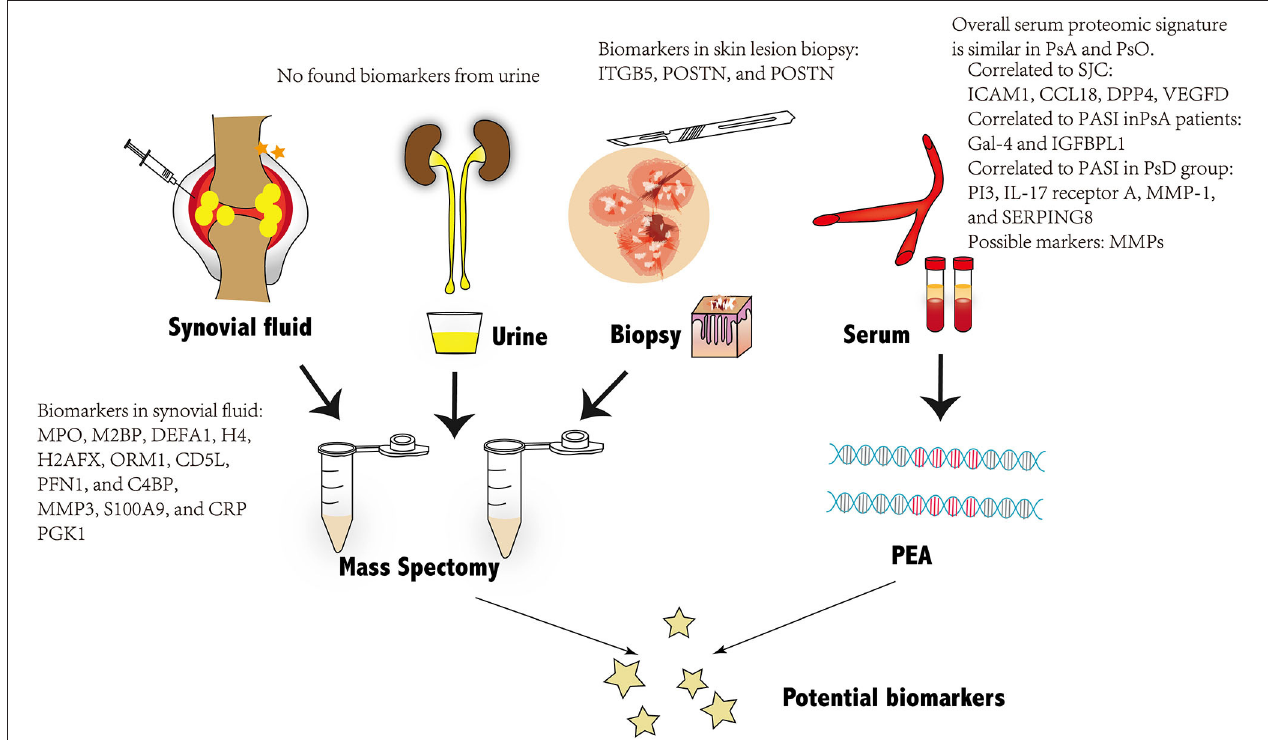
FIGURE 1 | Overview of the potential biomarkers of PsA found through proteomic technologies from four different kinds of biological samples: Biomarkers from synovial fluid and skin tissues are presented in the figure. No possible biomarkers are found from urine and serum. PsA, psoriatic arthritis; PEA, proximity extension